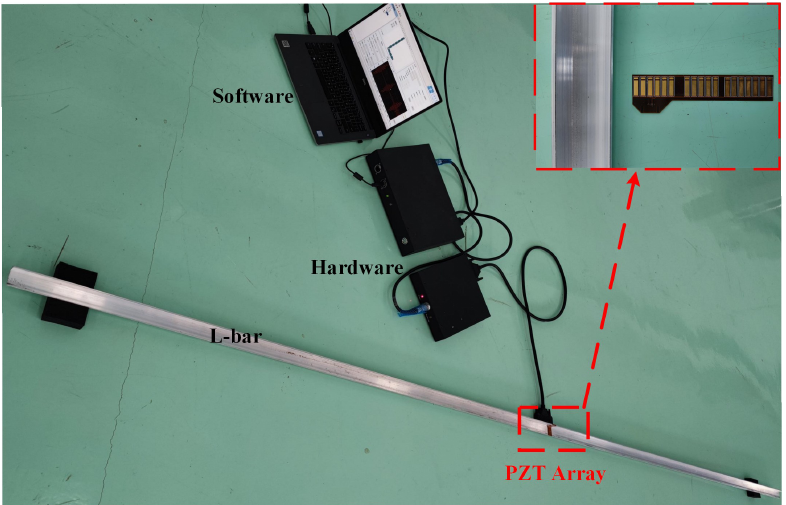
Figure 17. The experimental setup.